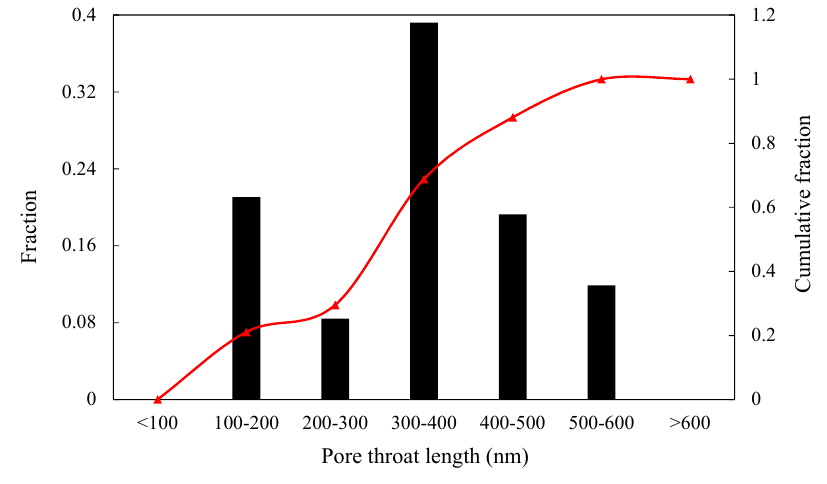
Figure 1. Coordination bond length distribution.